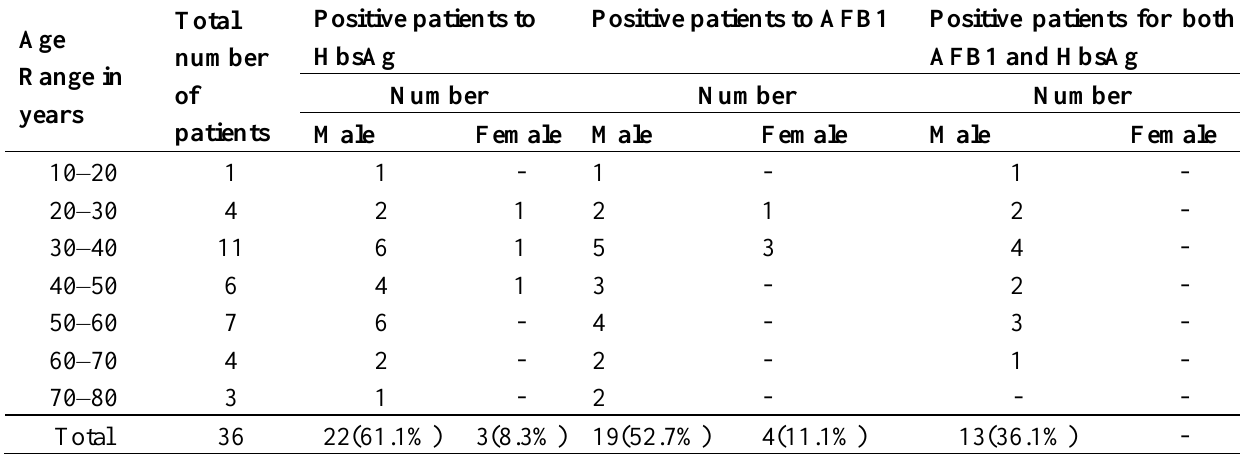
Table 5. AFB and HbsAg in sera of primary liver cancer patients from Yaounde hospital. 1